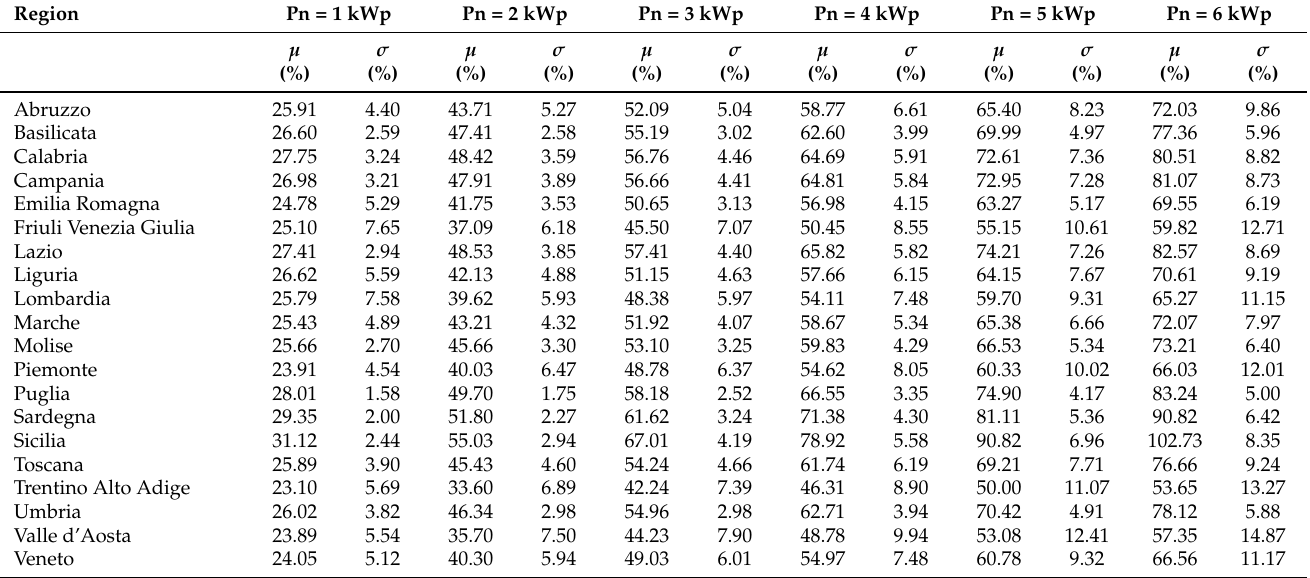
Table 11. Cost saving for E L = 2700 kWh with